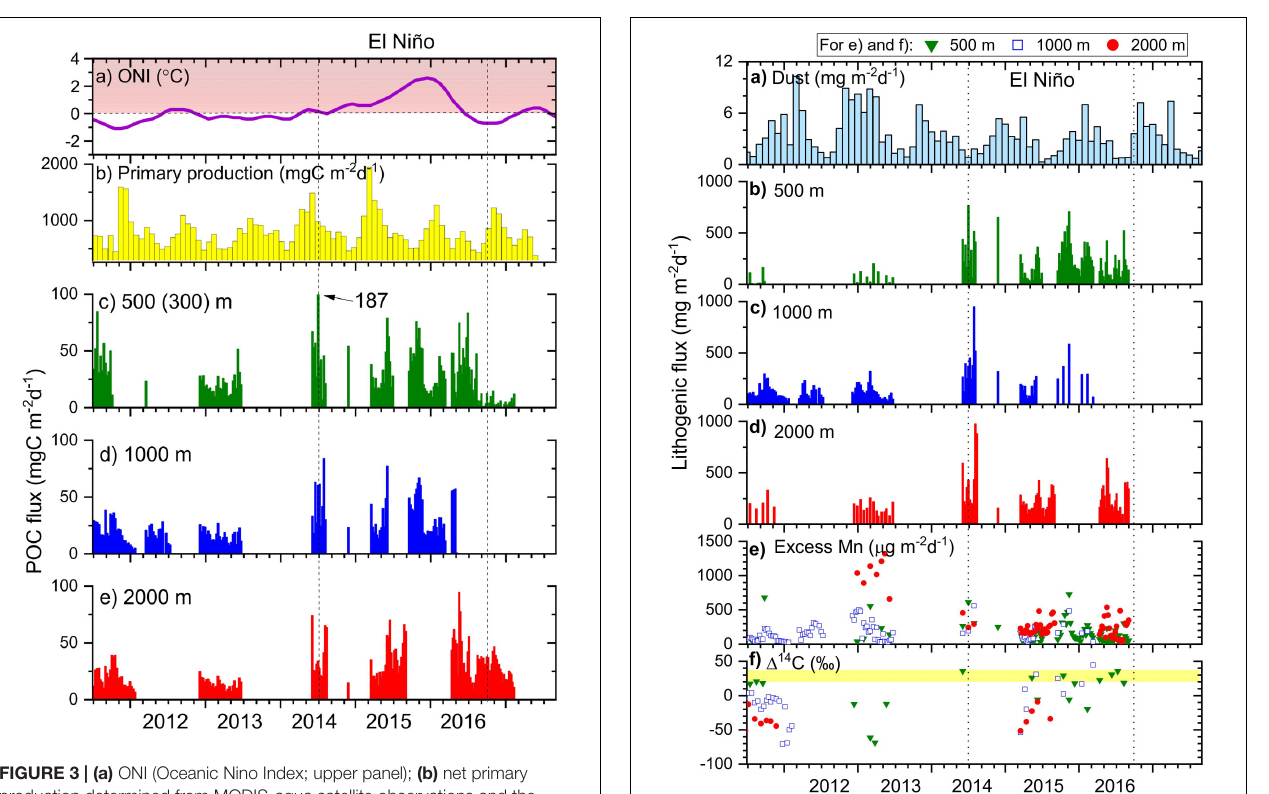
, n = 7; Kim (cid:104)